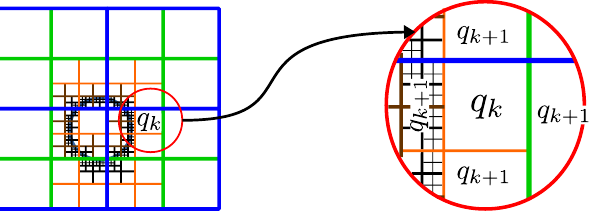
Figure 3. Neighbourhood structure. Quadtree decomposition neighbourhood.